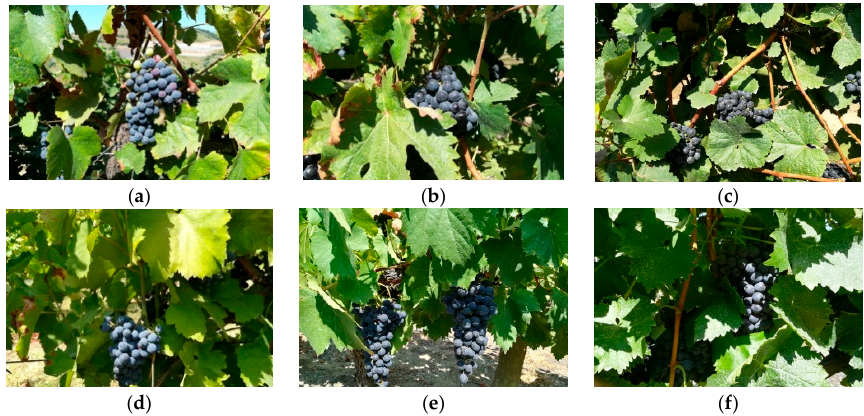
Figure 3. A sample of each one of the six red grape varieties of the DRGV_2018 database: ( a ) Touriga Nacional , ( b ) Tinta Roriz , ( c ) Touriga Franca , ( d ) Tinto Cão , ( e ) Tinta Barroca , and ( f ) Tinta Amarela .